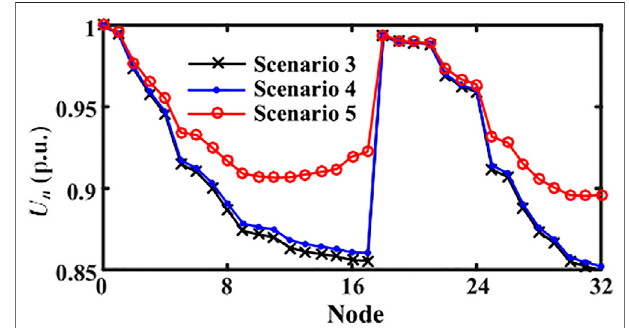
FIGURE 19 | Voltage curves under different scenarios at 19:00.